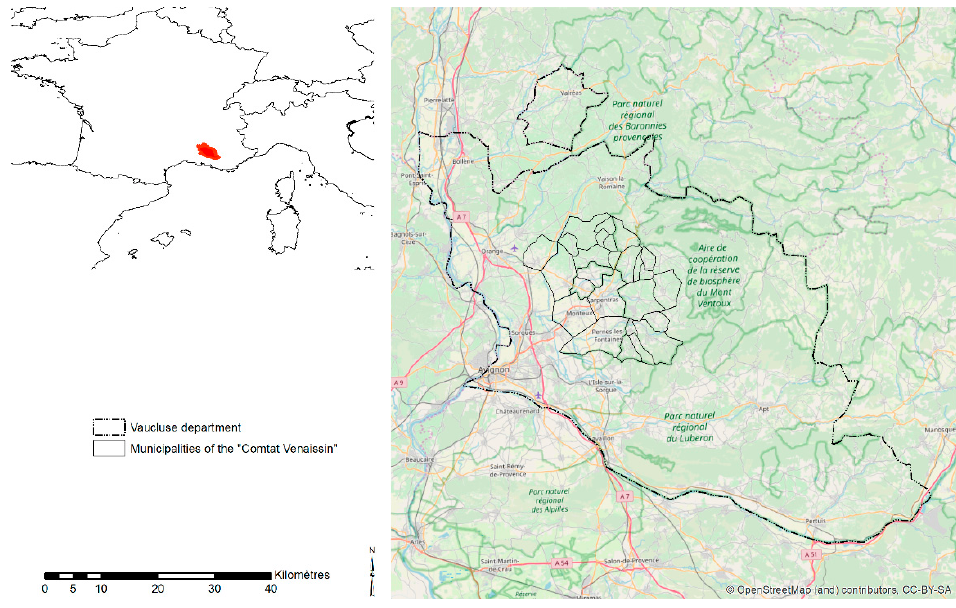
Figure 1. Localization of the study area.